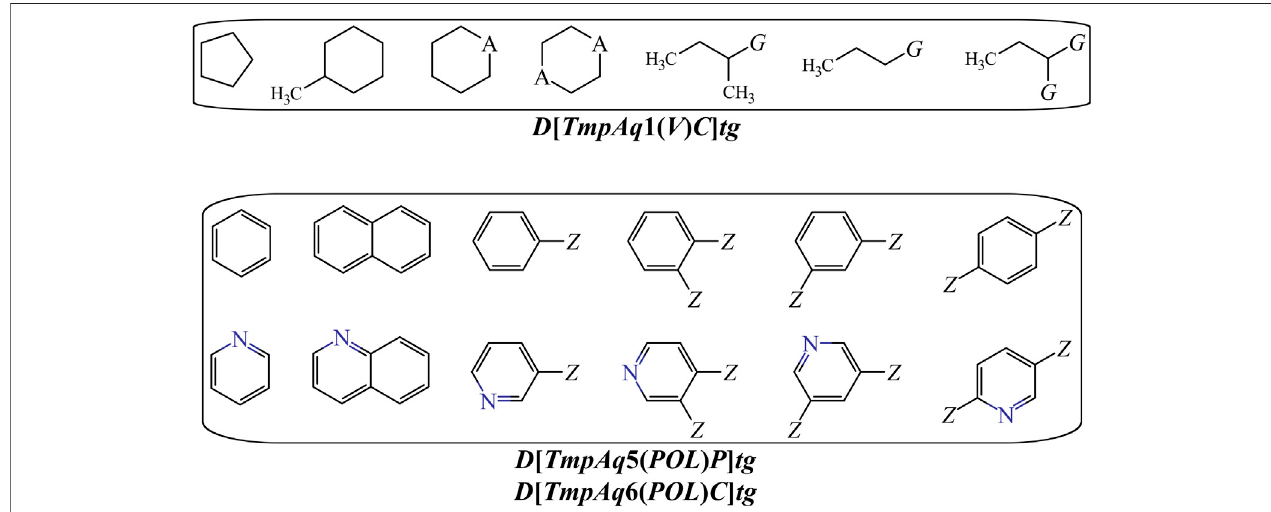
FIGURE 4 | Substructures exhibiting with positive contributions to the desirable increase of the V { D [ LmpAq1 ( V ) C ] tg } or the favorable variation of the POL { D [ LmpAq5 ( POL ) P and D [ LmpAq6 ( POL ) C ] tg }. Here, A (cid:1) − CH 2 − , − NH − , O, or S; G (cid:1) Cl, Br, or I; Z (cid:1) any group lacking aliphatic carbons.